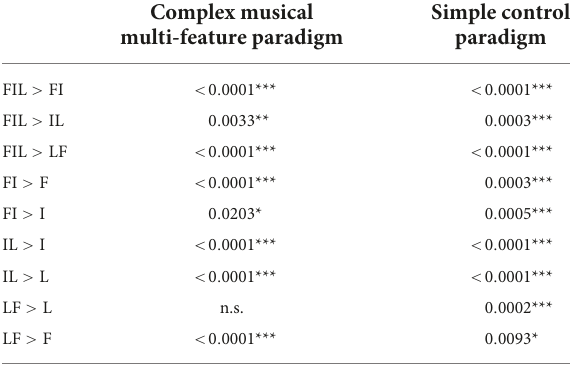
Complex musical multi-feature paradigm